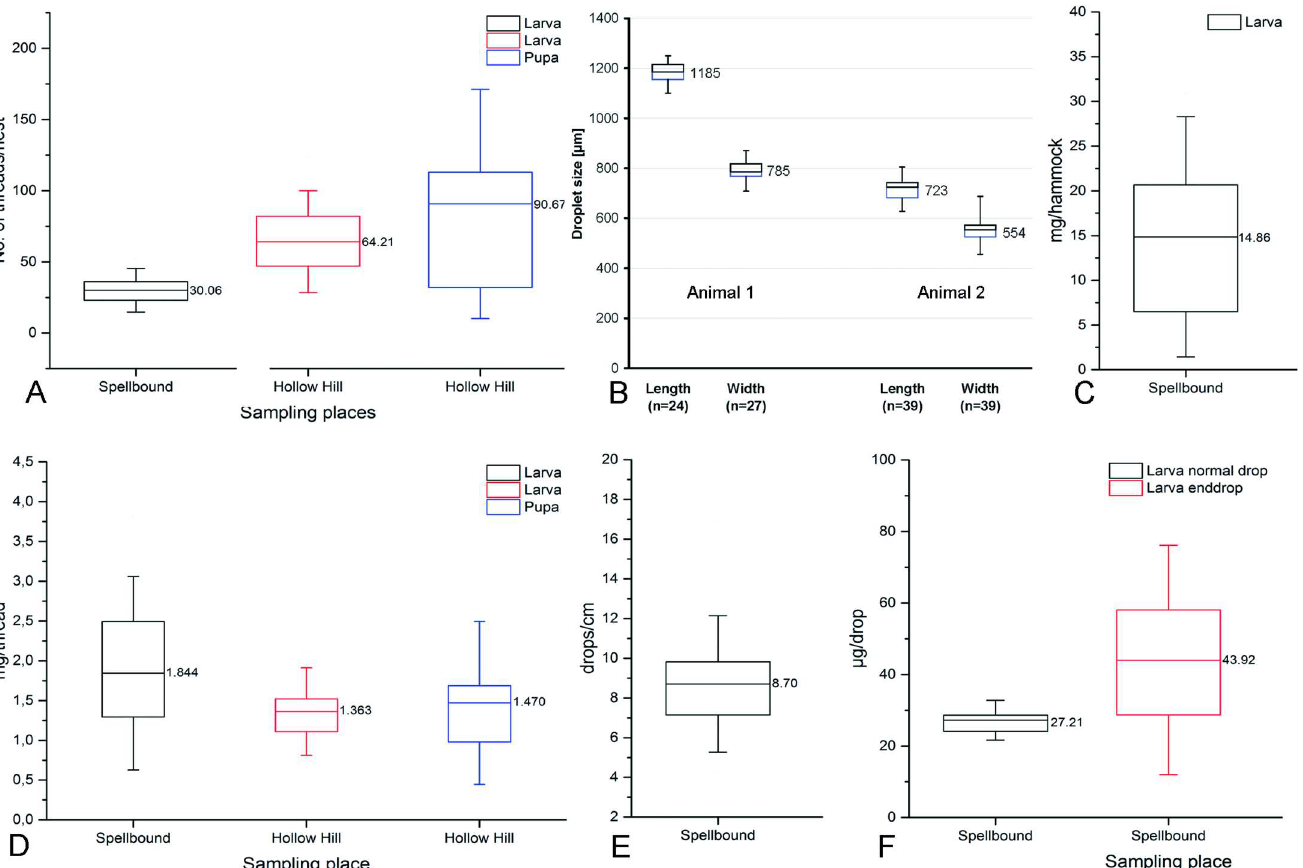
Fig 3. Evaluationof the New Zealandspecies A . luminosa indicatesthat A) the larva in the SpellboundCave producefewer threads (mean 30 per nest) in relationto those from HollowHill cave (mean 64 per nest) or the pupae (mean 90 per nest) from HollowHill. B) Droplets attached to glass slides have a greater length than width and vary betweenindividuals, e.g. 1185x785 μ m (length x width) in animal 1and 723x554 μ m in animal2. C) The hammock (excludingthreads and larva) from animalsin the SpellboundCave with a mean weight of 14.86 mg. Weight measurements with samples from the Hollow Hill cave could not be performed, as it is forbiddento remove a larva from its nest. D) Threads taken from the nest are much heavier (in mean 1.844 mg/ thread) in the SpellboundCave than those from HollowHill (1.36 mg) or producedby the pupae (1.47 mg). E) On average, the larva producearound8 droplets per cm thread length, with F) a estimated weight of 27.21 μ g for the normal droplet and almost 44 μ g for the final dropletat the thread